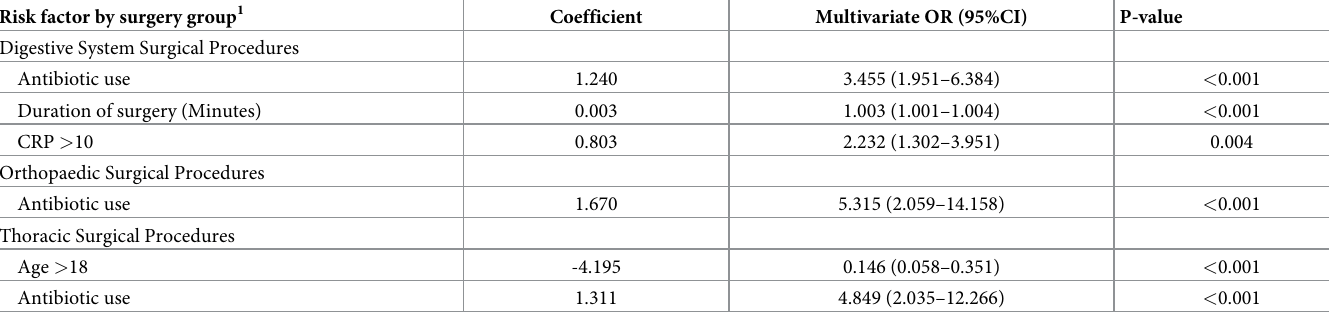
Table 3. Multivariate analysis risk factors for the occurrence of SSI by group of surgeries using standard medical